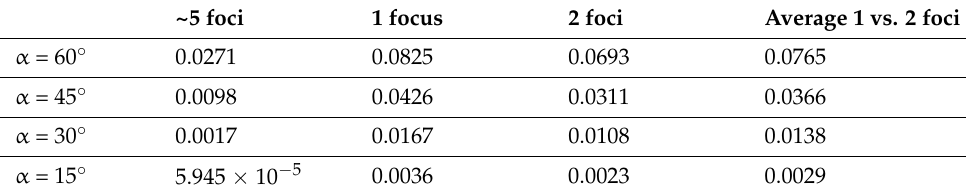
In Table 3, the same example is considered. In the first column, the angle defining the